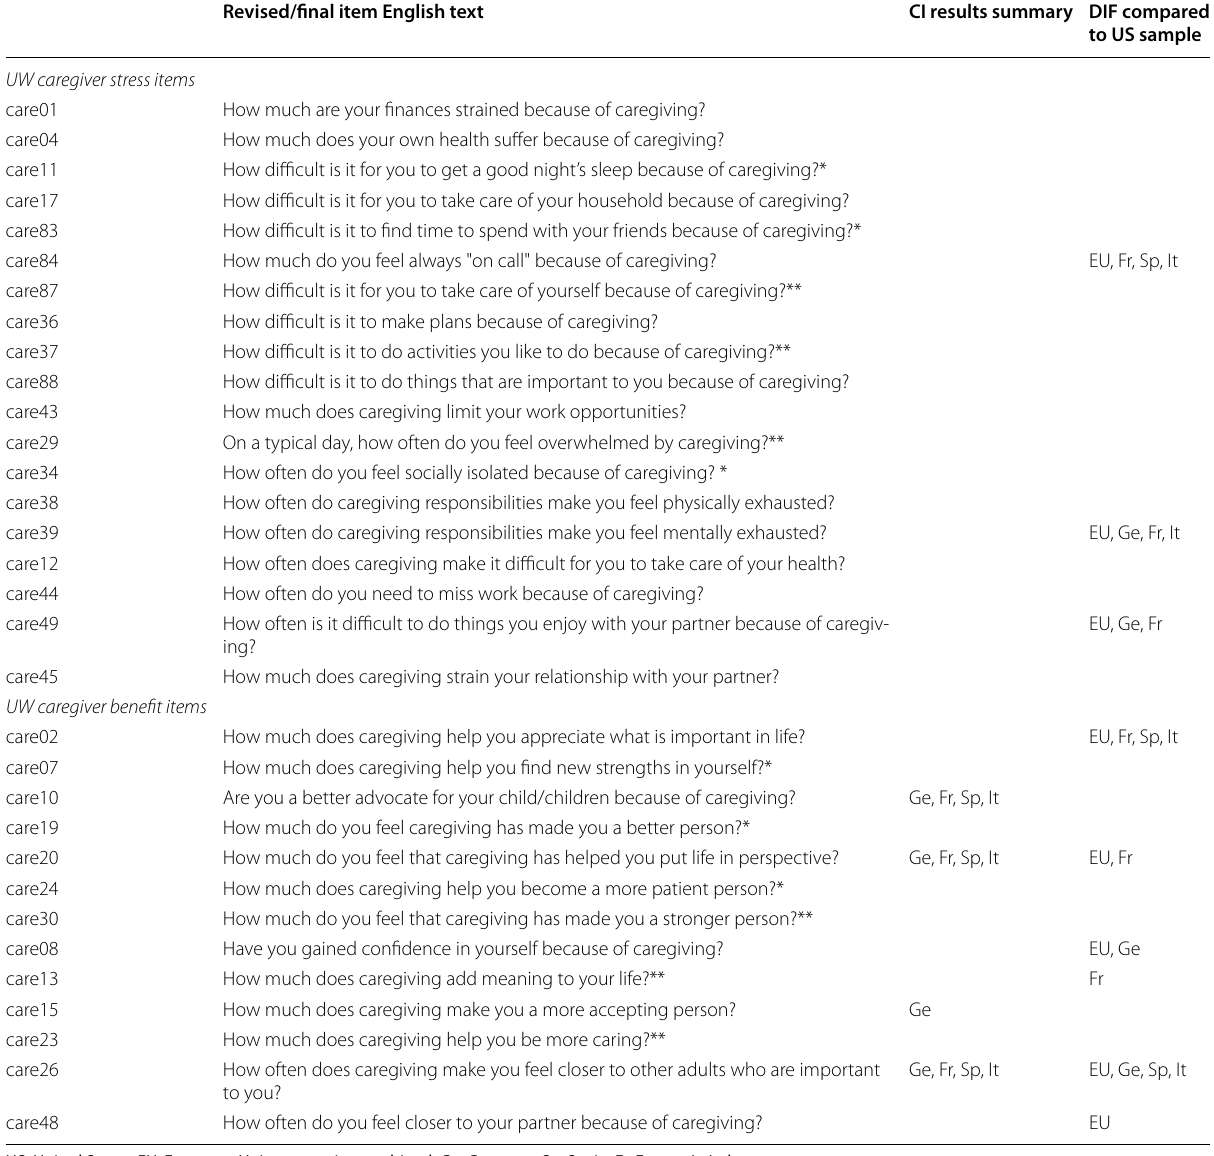
Table 2 Summary of cognitive interview and differential item functioning results for the final translated UW-CSS and UW-CBS